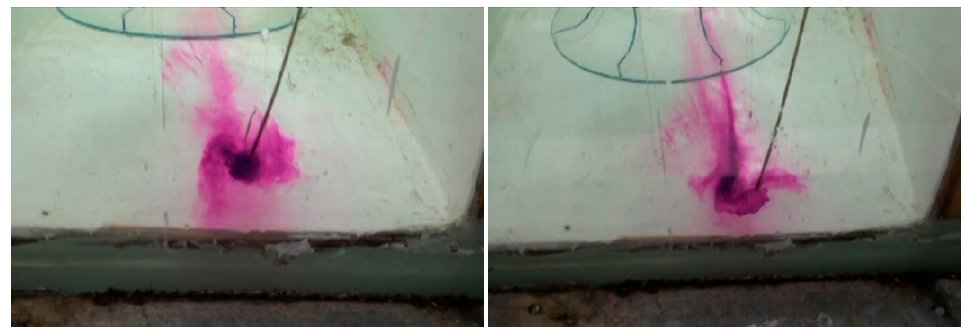
Figure 12. Backwall submerged vortex type 2 to type 3 as evidenced by the solid dye core.